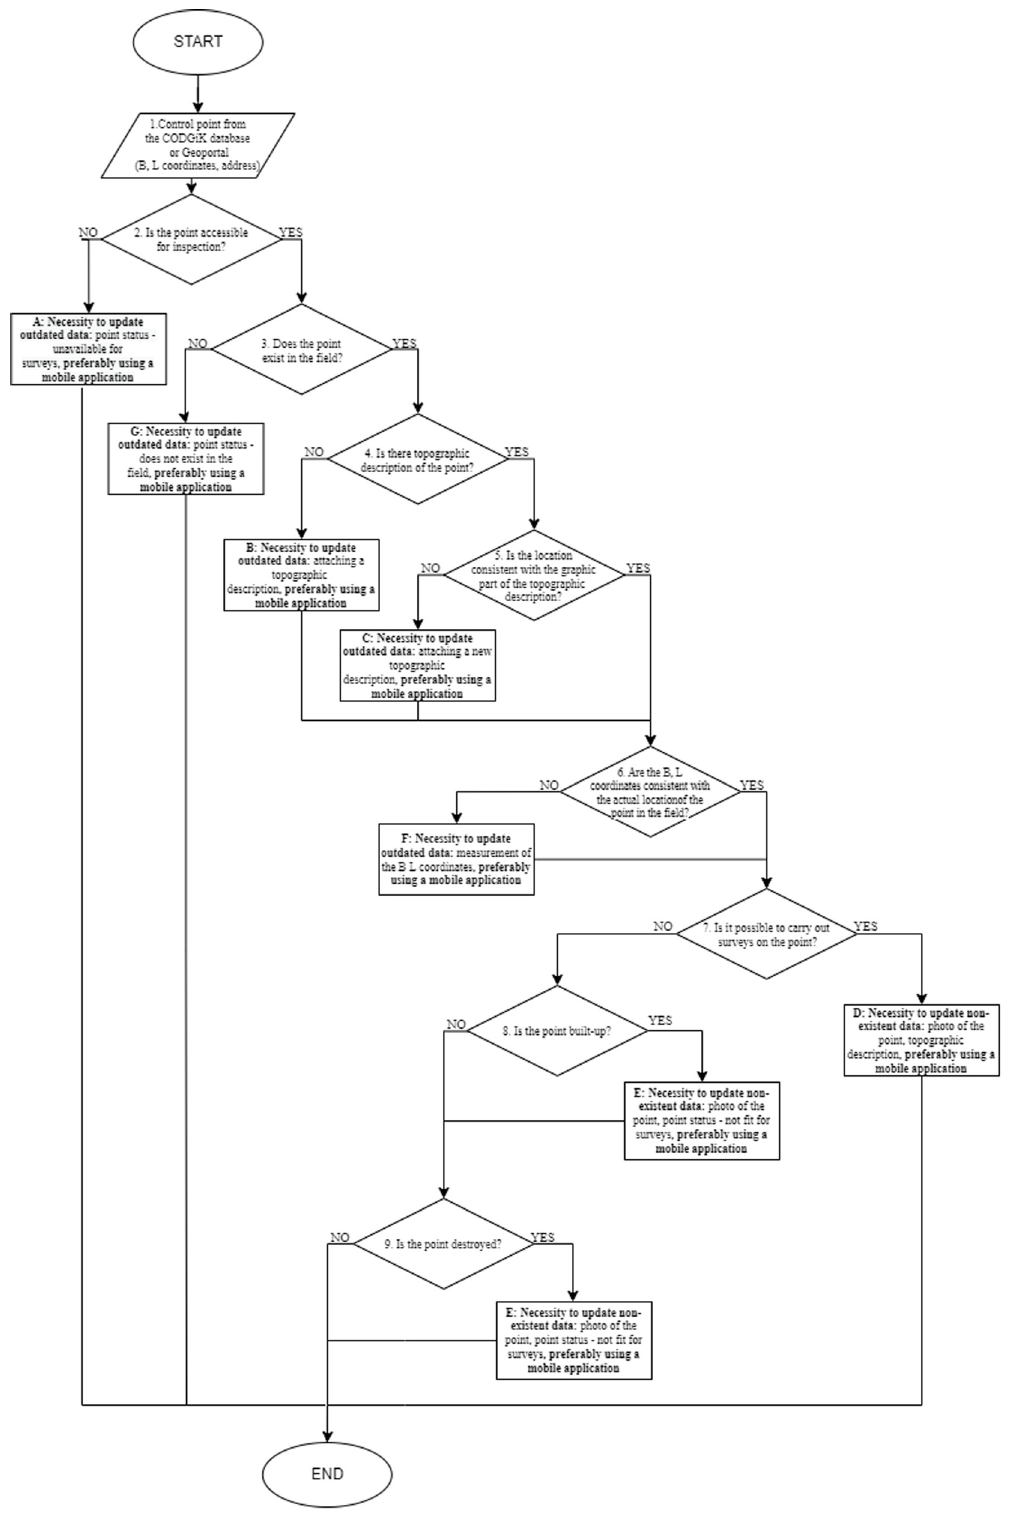
Figure 8: Diagram of control network analysis according to the adopted criteria. Source: Authors ’ original